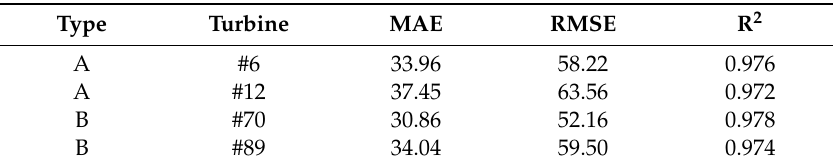
Table 5. Performances of stacking model on test